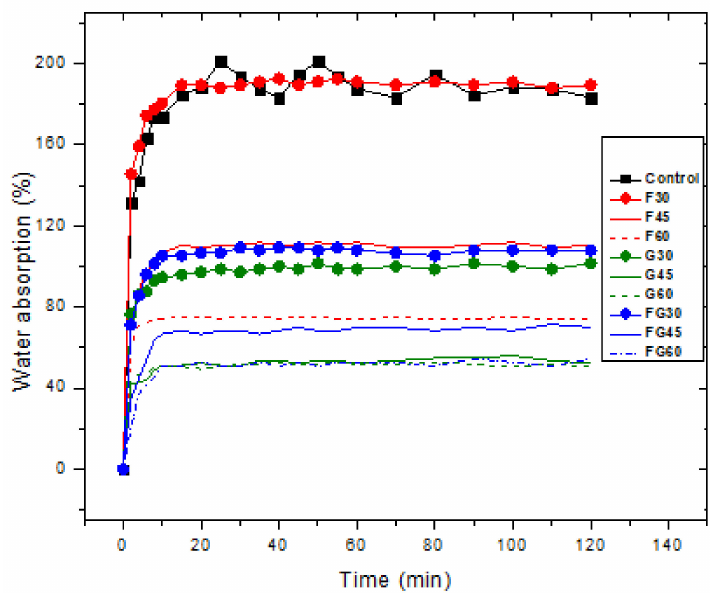
Figure 4. Water absorption for biofilms using different plasticizers at varying